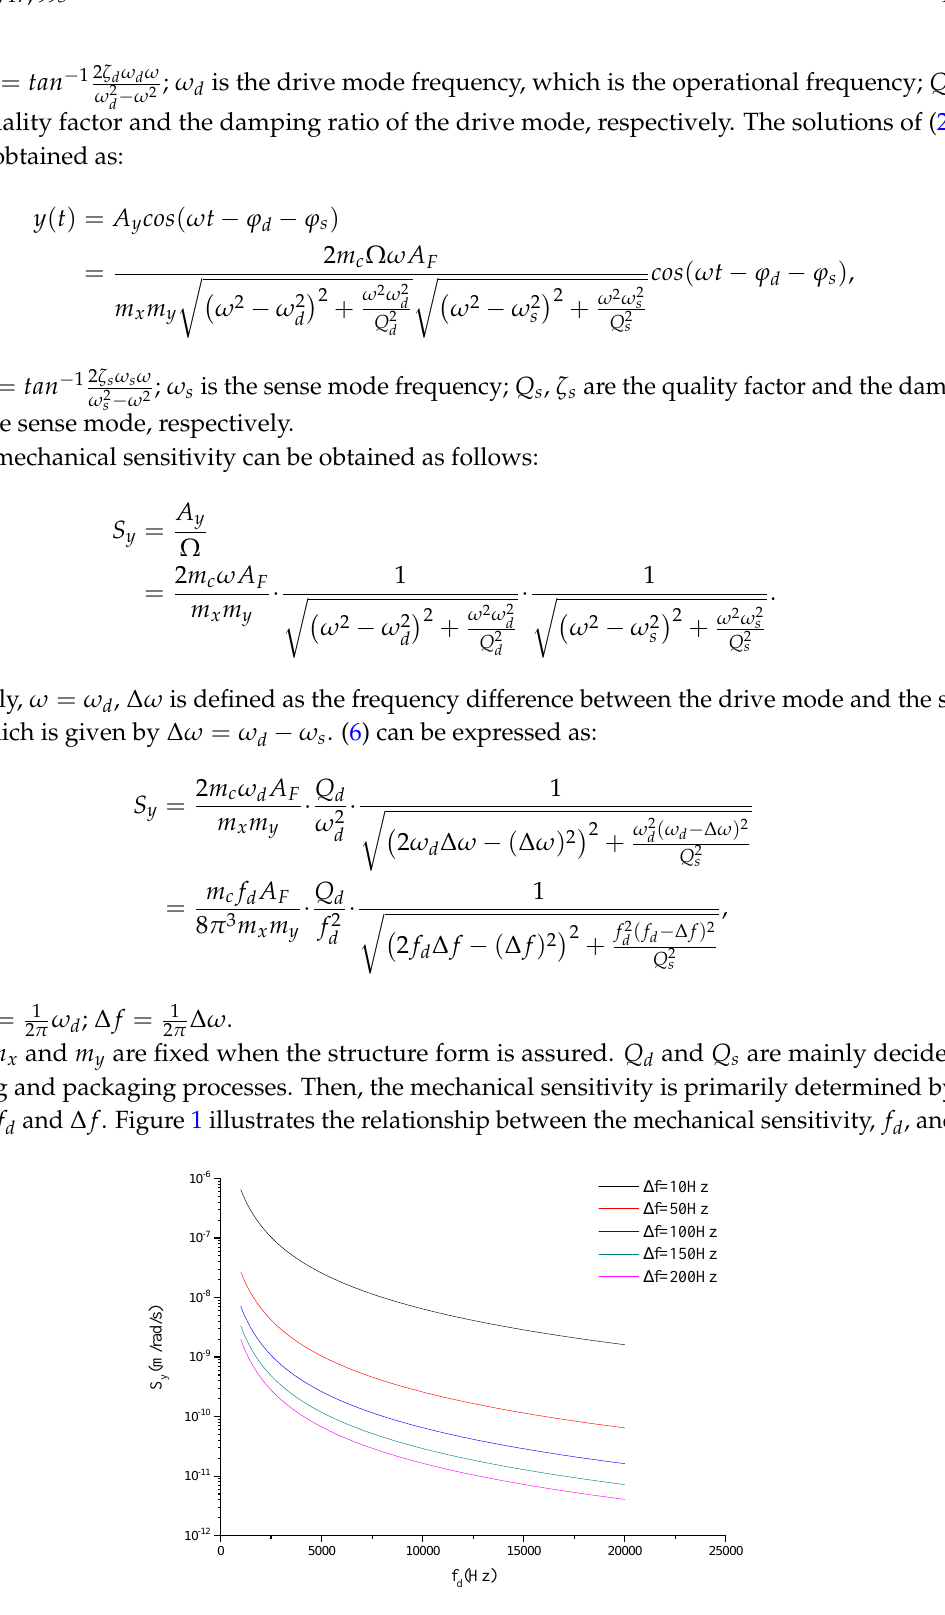
Figure 1. The curves of the mechanical sensitivity related to ∆ f and f d